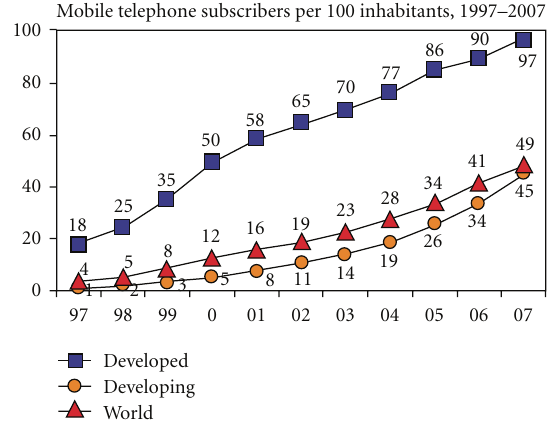
Figure 1: Source: http://www.itu.int/ITU-D/ict/statistics/ict/index